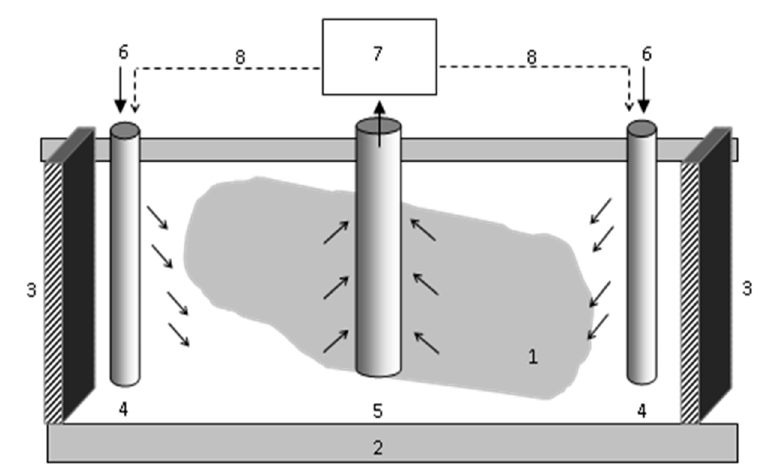
Figure 2. In situ soil flushing: polluted ground (1), low permeable zone (2), physical barrier (3), injection well (4), extraction well (5), washing solution (6), spent washing solution (SWS) treatment module (7), reinjection of treated SWS (8).